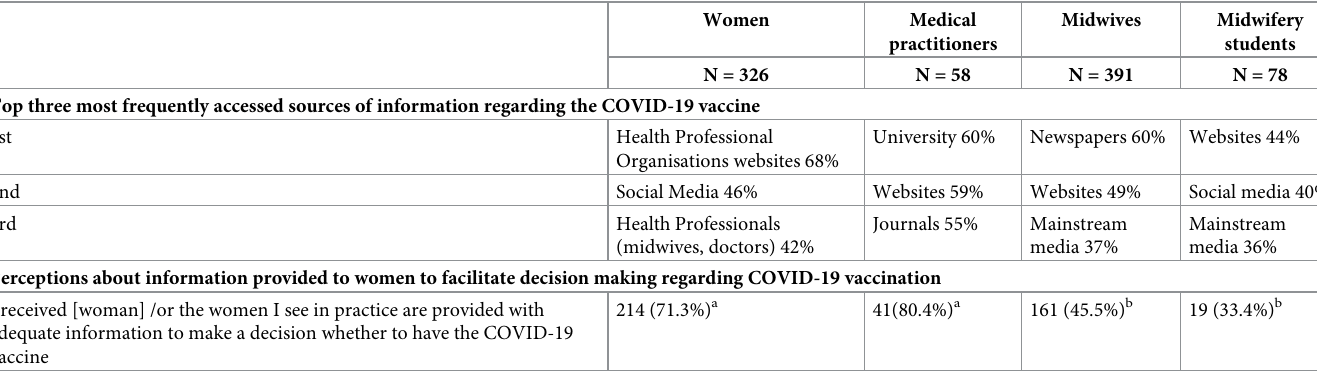
Table 4. Sources of information regarding the COVID-19 vaccine and perceived value.